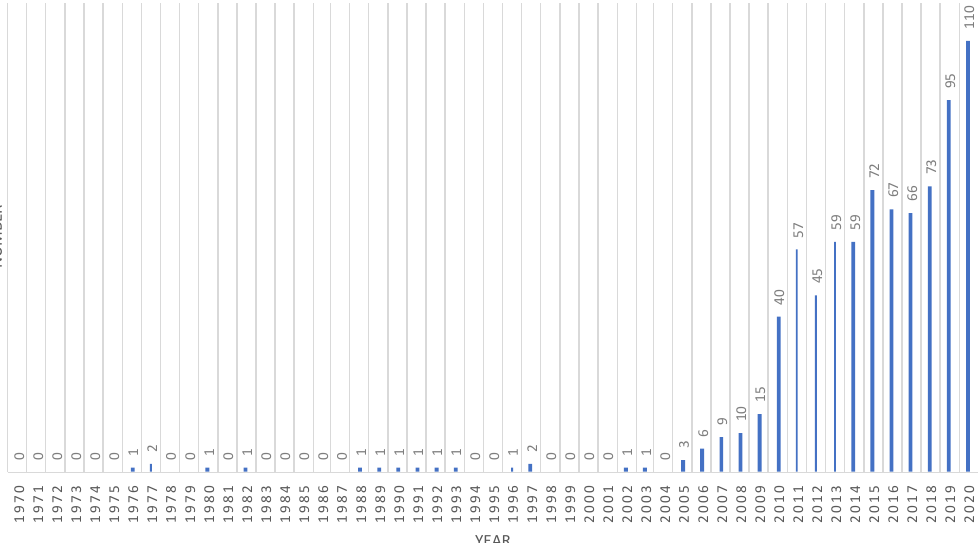
Figure 1. Number of articles by publication year.